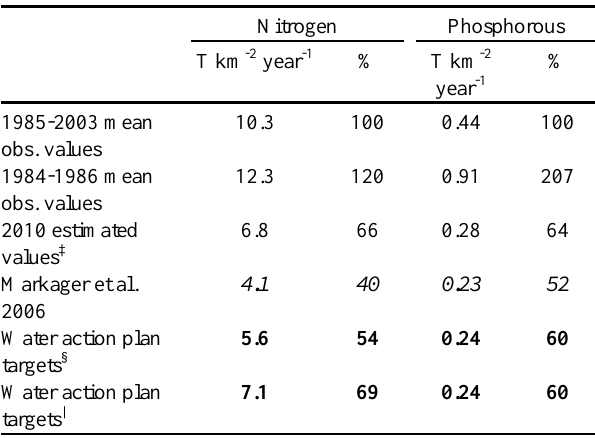
Table 2. Total nutrient loadings in the Limfjord. Mean values (tons km -2 year -1 ) and proportions relative to the mean values used for the ecological-social-economic (ESE) model calibration period from 1985-2003 †